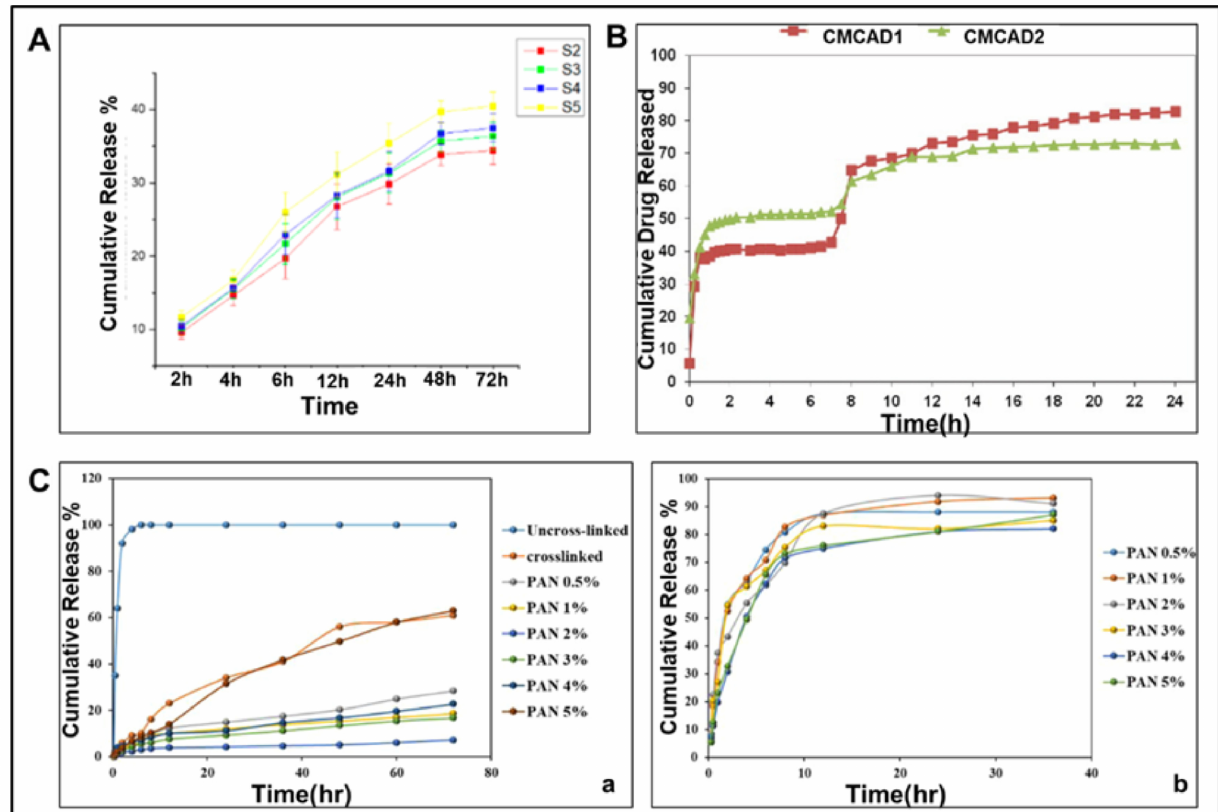
Figure 10. Comparison of drug release profiles from single-drug PAN-based nanofibers, PVA-based nanofibers, and dual-drug PVA/PAN nanofibers with a core-shell structure. ( A ) Drug release profiles of DLF-loaded PAN nanofibers [192] (S2–S5, DLF content of 3, 4, 5, 6 wt% PAN nanofibers, respectively); ( B ) Drug release profiles of DSs-loaded PVA nanofibers, Reprinted with permission from [227] copyright 2016, Taylor & Francis. ( C ) Drug release profiles of PVA-DSs/PAN-GENs core- shell nanofibers [195]. ( a ) Drug release profiles of core DSs; ( b ) drug release profiles of shell